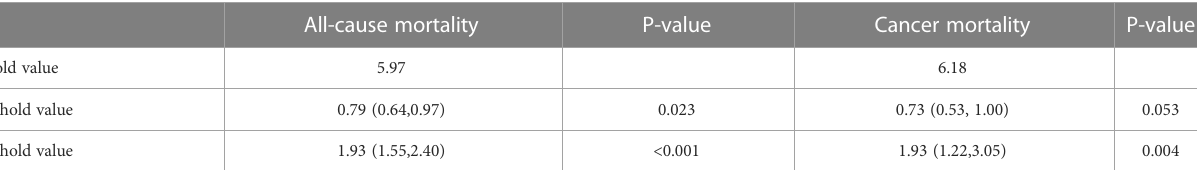
TABLE 3 Nonlinearity addressed through two-piecewise linear